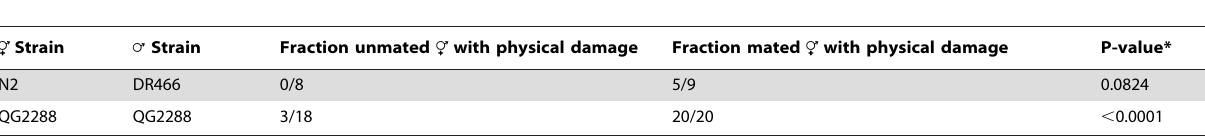
Table 1. Incidence of vulva cuticle damage in mated and unmated hermaphrodites.